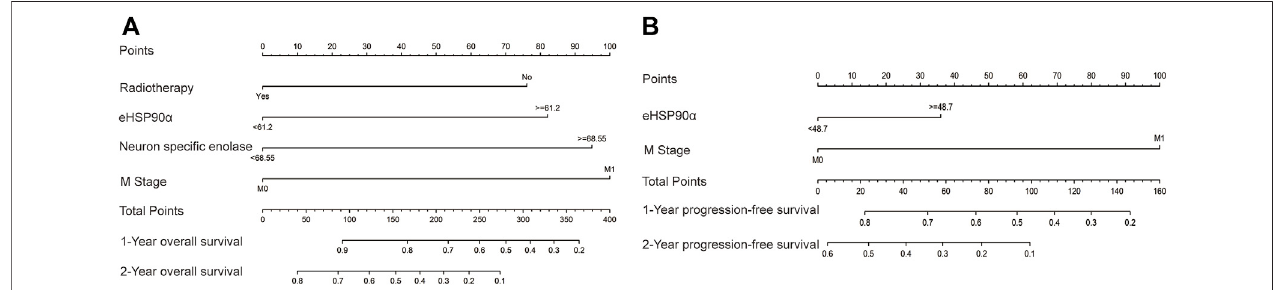
FIGURE4 | Nomograms of SCLC prognosis (A) The prognostic nomogram for overall survival (OS) based on the prognostic scores ofeHSP90 α and other factors in SCLC patients (B) The prognostic nomogram for progression-free survival (PFS) based on the prognostic scores of eHSP90 α and M stage in SCLC patients.